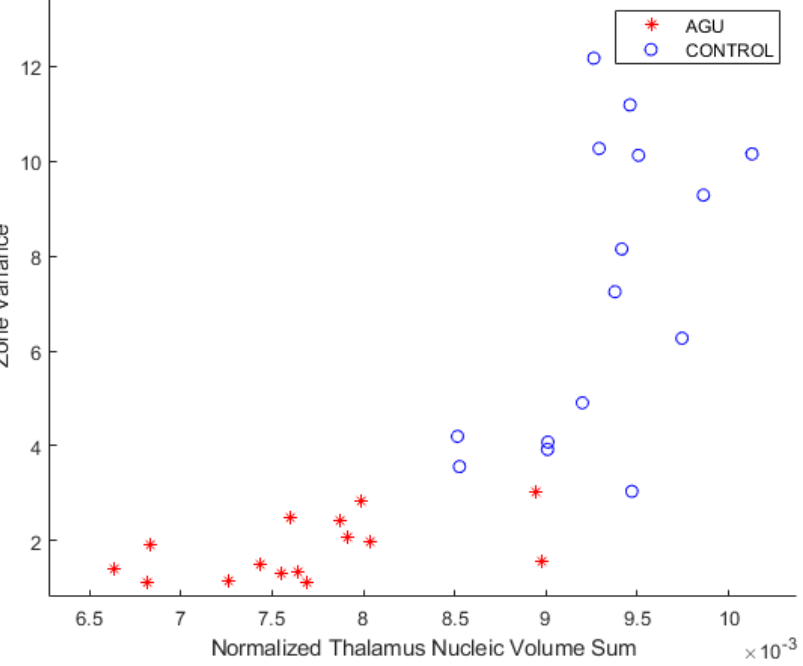
Figure 5. Zone variance calculated from the SWI, plotted against the sum of the thalamic nucleic volumes. Patient and control groups are separated in both x - and y -axes. Zone variance is on par with the thalamus volume as a classification feature.